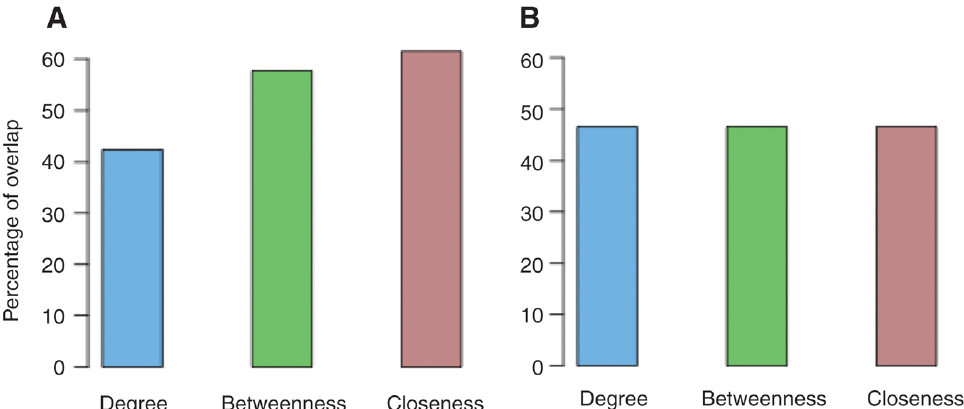
Figure 5: Overlap of most central nodes (according to three different centralities) with the set of genes and miRNAs in the statistically enriched motifs. (A) Conserved. (B)